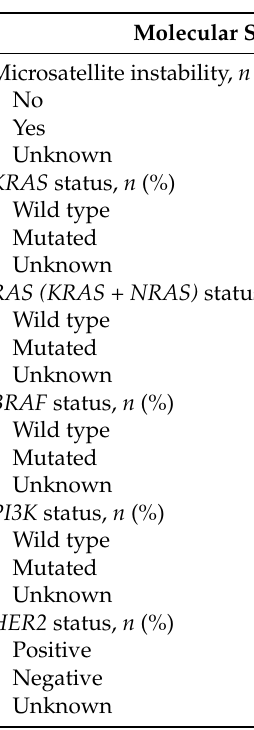
Table 2. Primary tumour molecular status ( n =